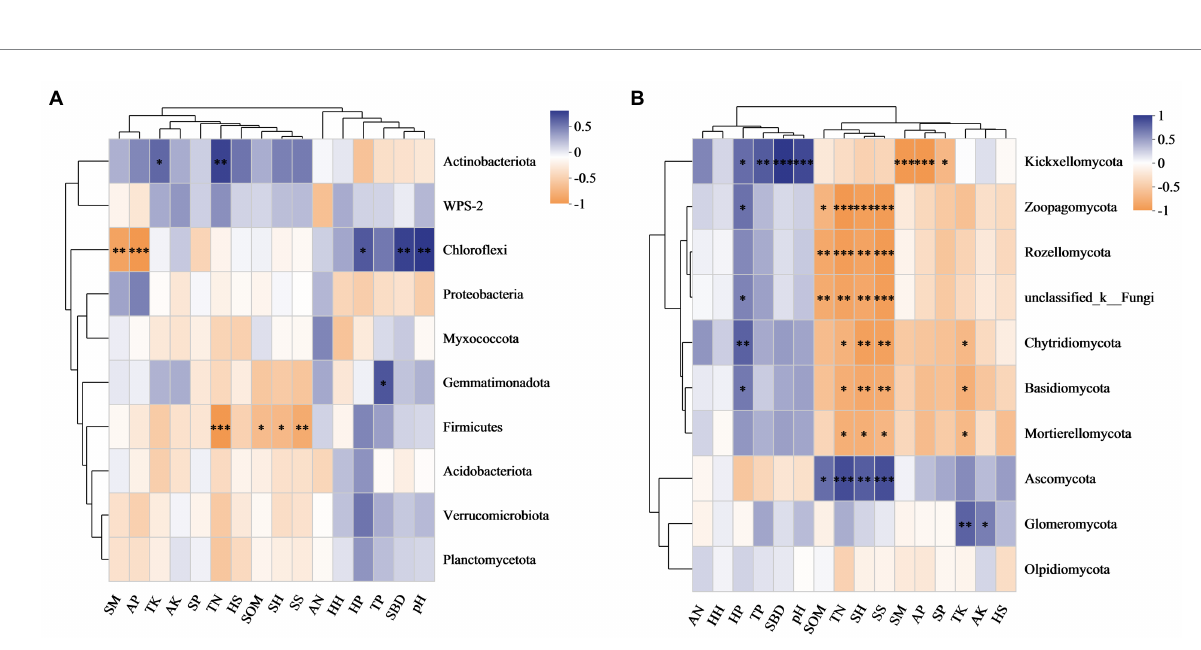
FIGURE 4 Correlation heatmaps of the abundance of bacterial (A) and fungal (B) communities at the phylum level with understory vegetation characteristics and soil properties. HH, HP, HS, SH, SP and SS denote the Shannon index, Pielou index and species richness in the herb and shrub layers, respectively. SM, soil moisture; SBD, soil bulk density; SOM, soil organic matter content; TN, TK, TP, AN, AK and AP, contents of total nitrogen, potassium, phosphorus, available nitrogen, potassium and phosphorus,